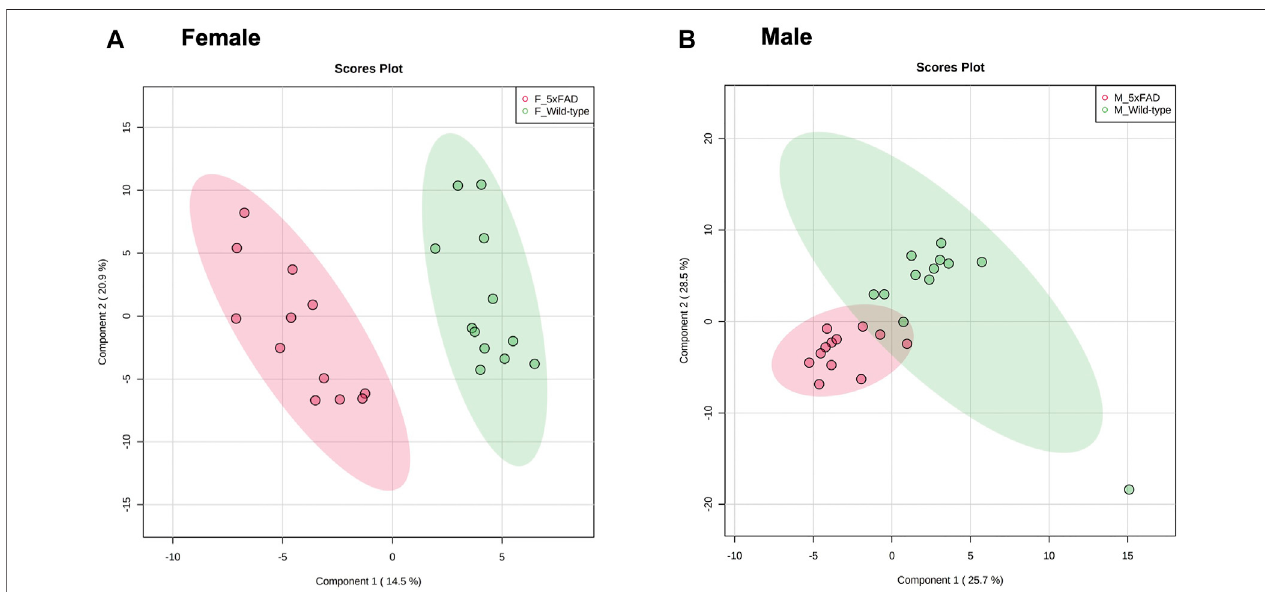
FIGURE 1 | PLS-DA plots of untreated female and male 5xFAD mice compared to untreated wild-type (WT) mice.